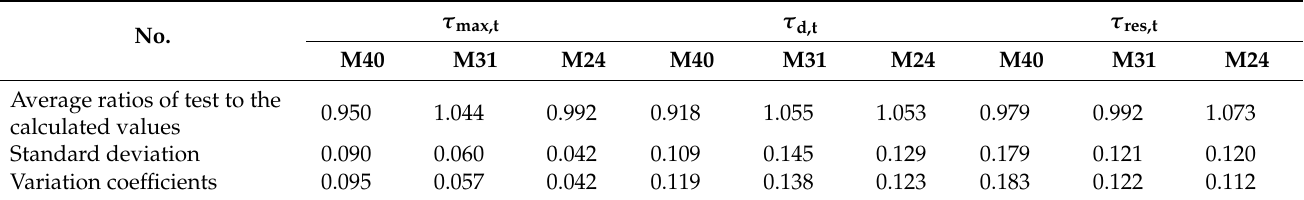
Table 4. Comparison results between test and calculated values of bond strengths.